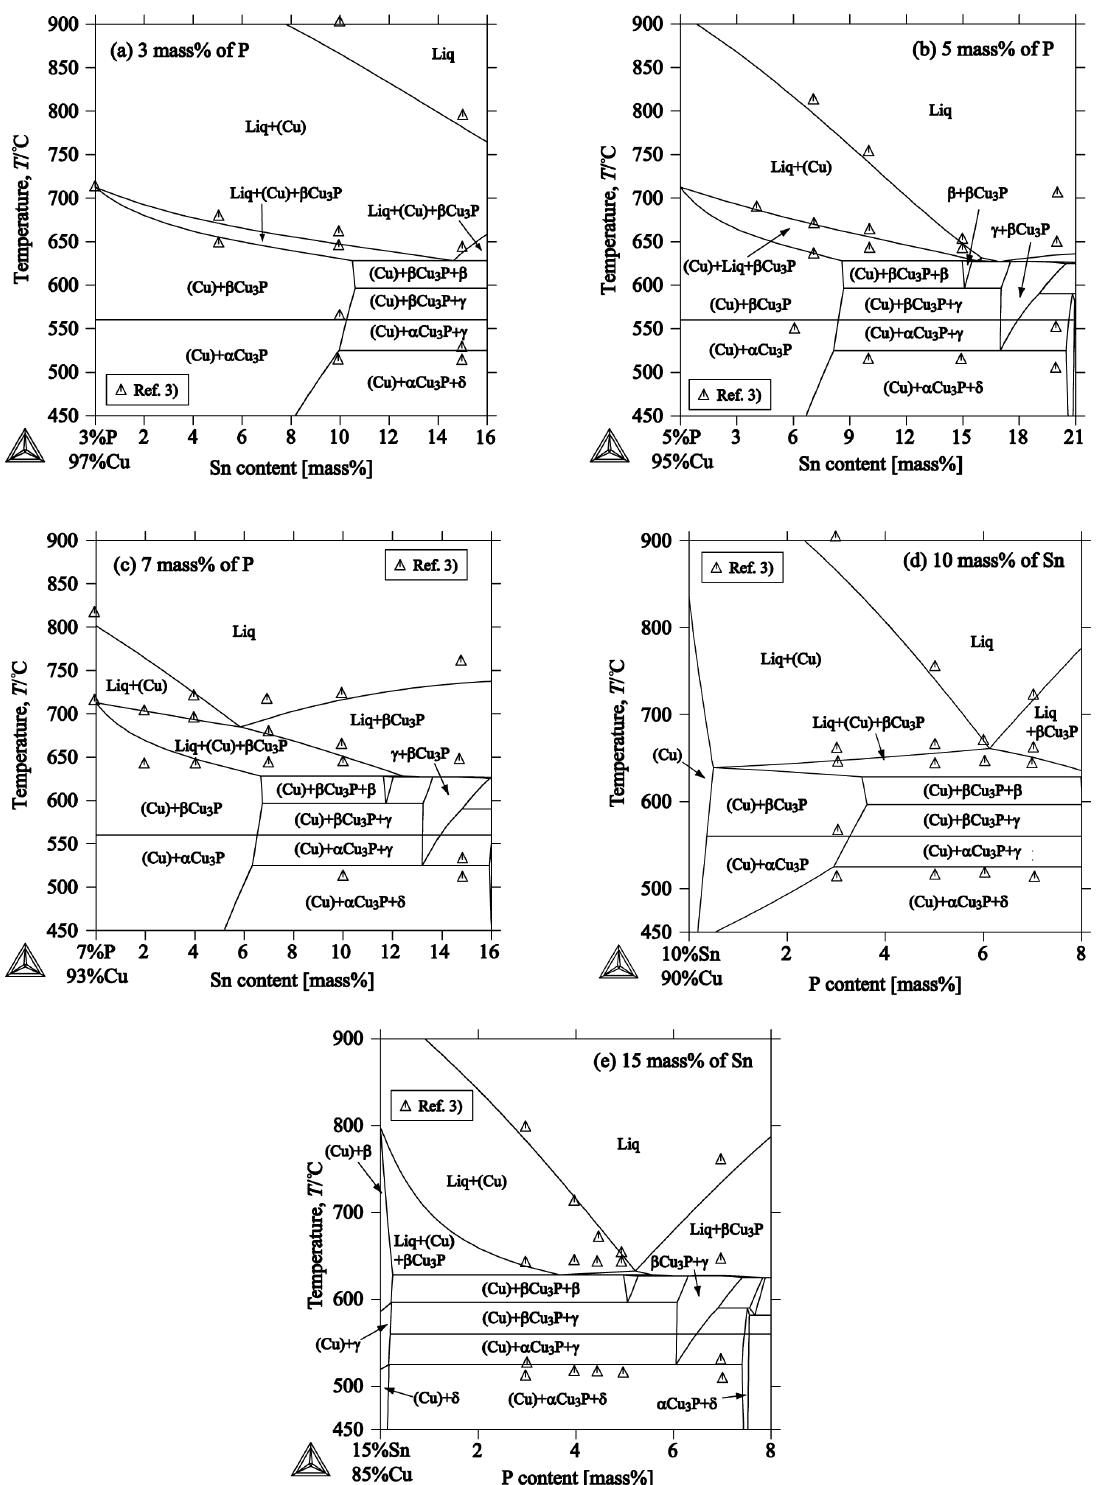
Figure 8. Comparison of calculated isopleths and experimental phase fields at (a) 3 mass% P, (b) 5 mass% P, (c) 7 mass% P (d) 10 mass% of Sn, and (e) 15 mass% of